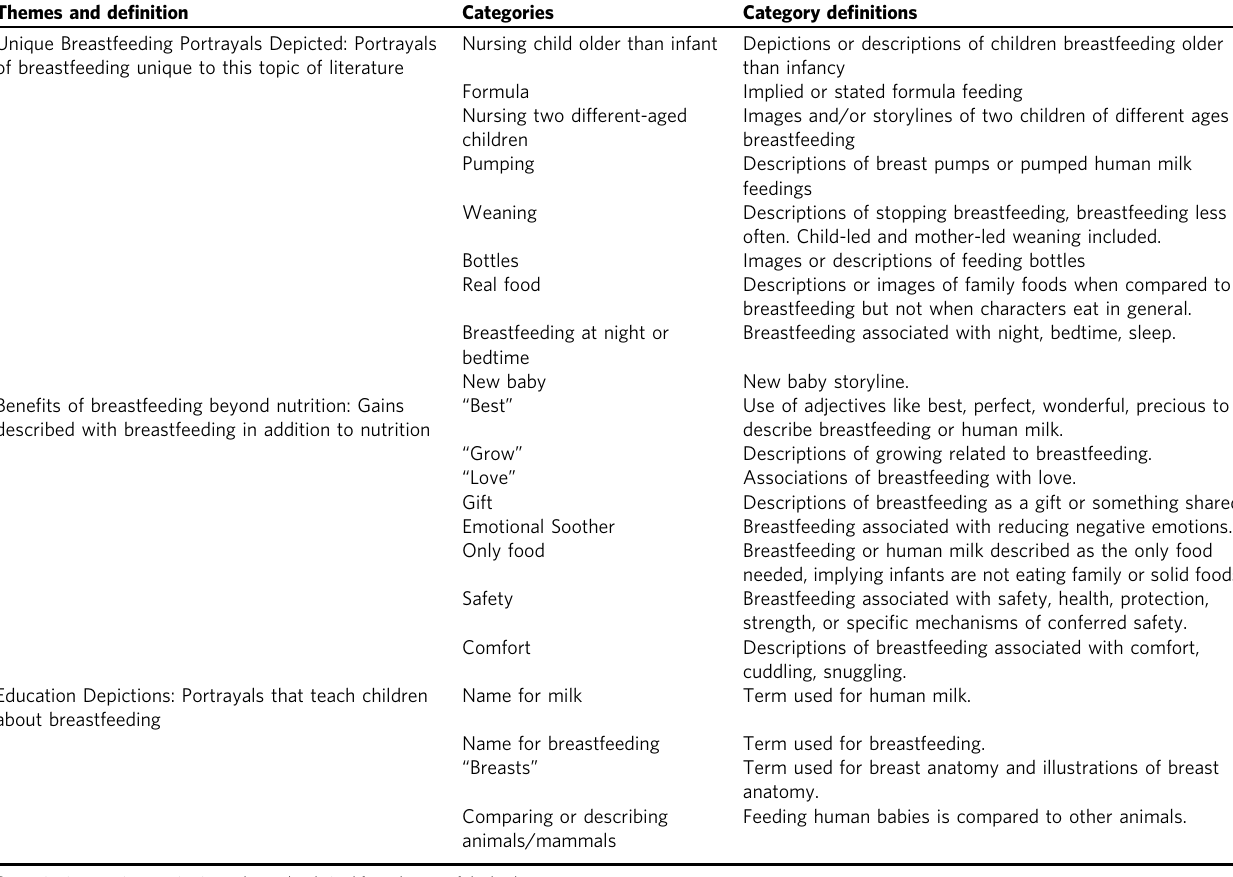
Table 3 Data analysis structure and de fi